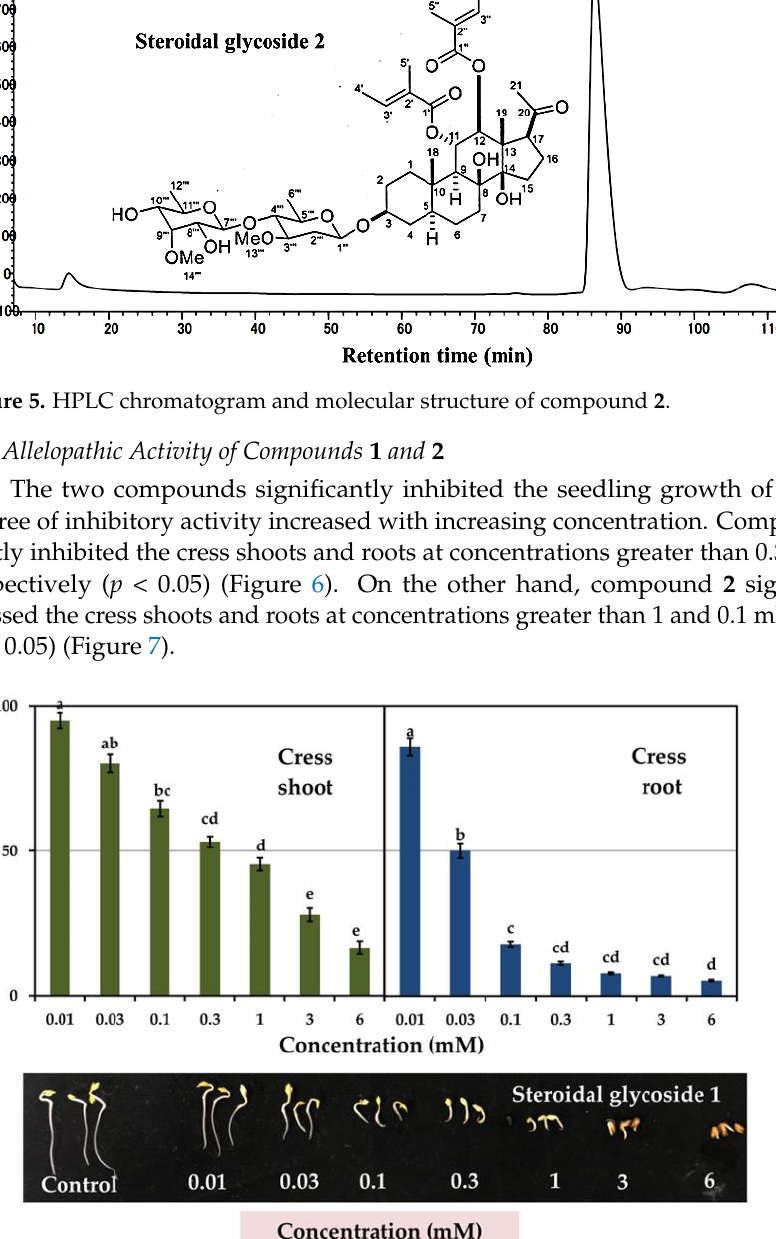
experiment express mean ± SE with three replicates ( n = 30). Different letters indicate significant differences among the treatments (Tukey’s HSD, p < 0.05).